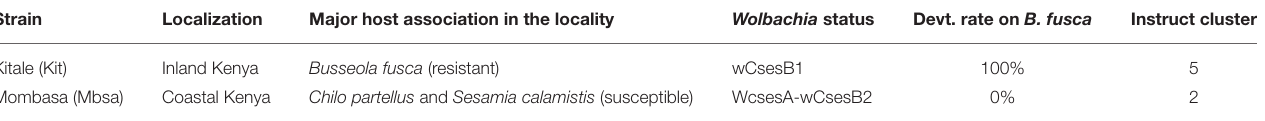
TABLE 1 | Status of the Kitale and Mombasa strains (Mochiah et al.,